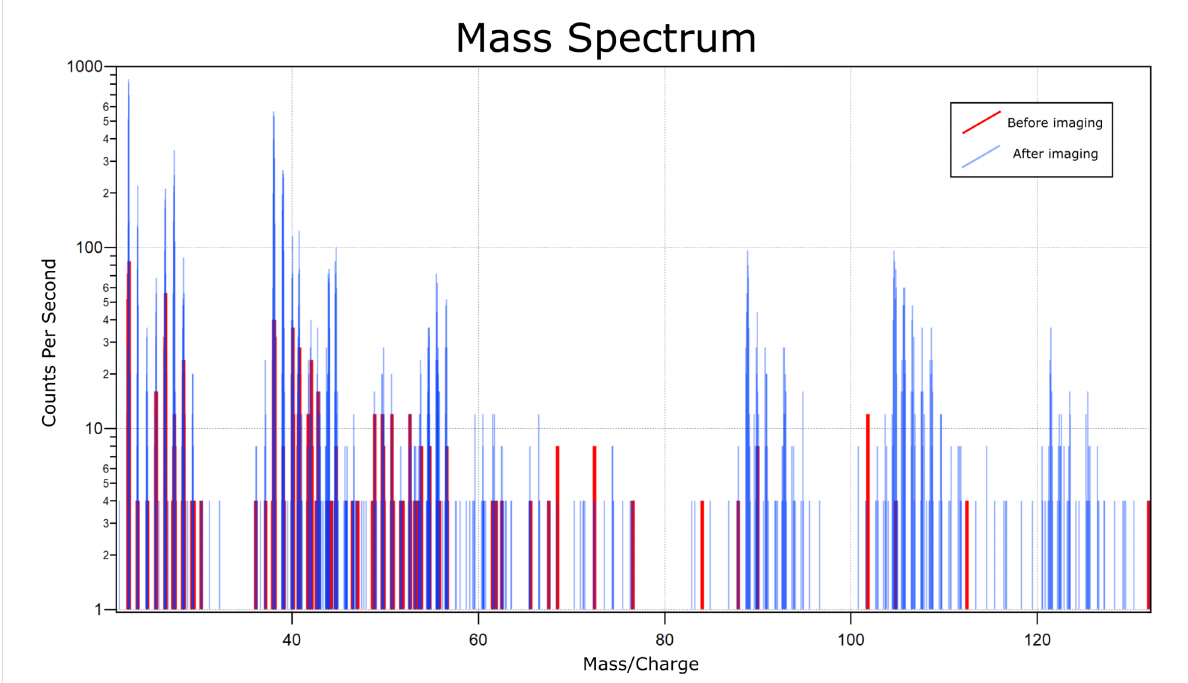
Figure 1: Mass spectra of a natural zircon sample before rastering with the primary beam (red) and after rastering with the primary beam for 240 min (blue). Count rates increase dramatically after the sample coating has been removed.